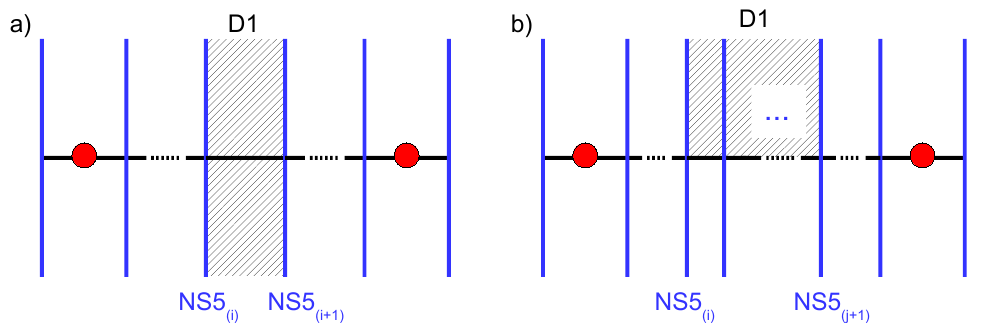
, b) (cid:0) u (cid:0) , c) ’ i . i i